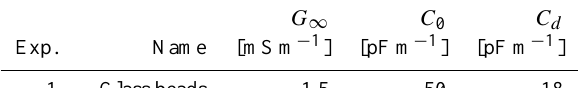
Table 3. Parameter sets characterizing the C-G relations for inver- sion of the reflectograms into soil moisture profiles both for glass beads and soils. G ∞ C 0 C d Exp.